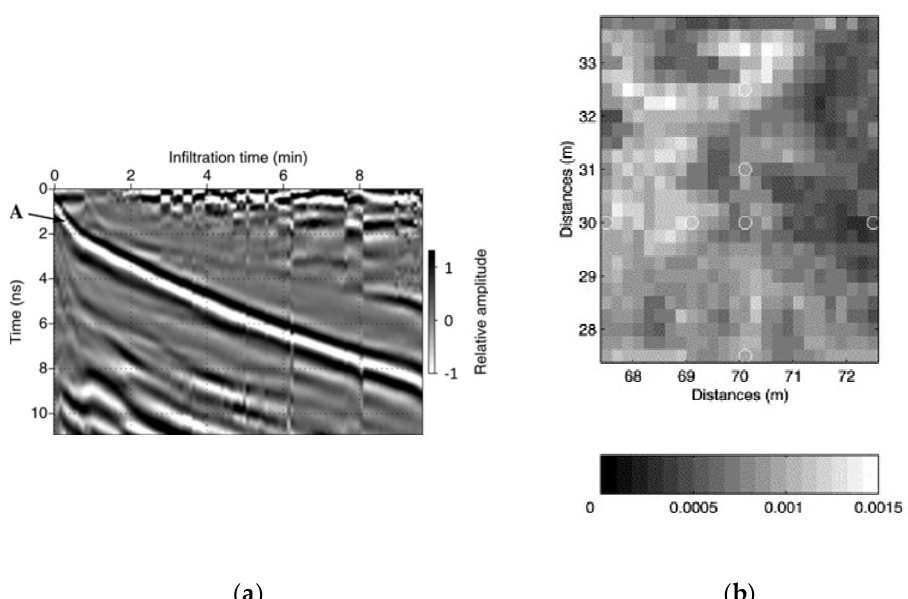
Figure 10. GPR prospecting for soil hydraulic properties. ( a ) Time-lapse GPR data acquired during constant head infiltration (reflection A is the wetting front) [305]. ( b ) Estimated horizontal distribution of hydraulic conductivity in a saturated sand layer using common mid-point velocity estimation and Kozeny–Carman relationships [311].